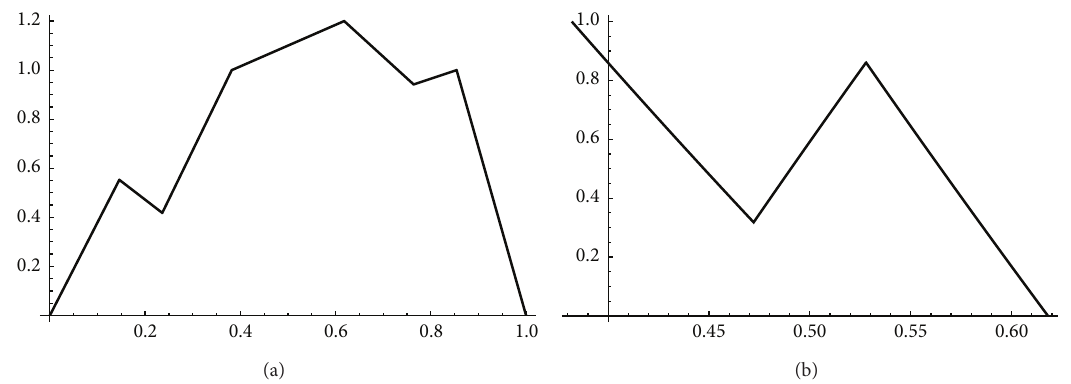
Figure 14: Example of spline density 𝑝(𝑥) from Proposition 13 (a). Here 𝑦 2 = 1.1 , 𝑦 3 = 1.2 , 𝑦 5 = 1 , and 𝑦 4 = (1/(1−𝑎))𝑦 3 −𝑦 2 . Corresponding function 𝛼 1 (on [𝑎, 1 − 𝑎] )